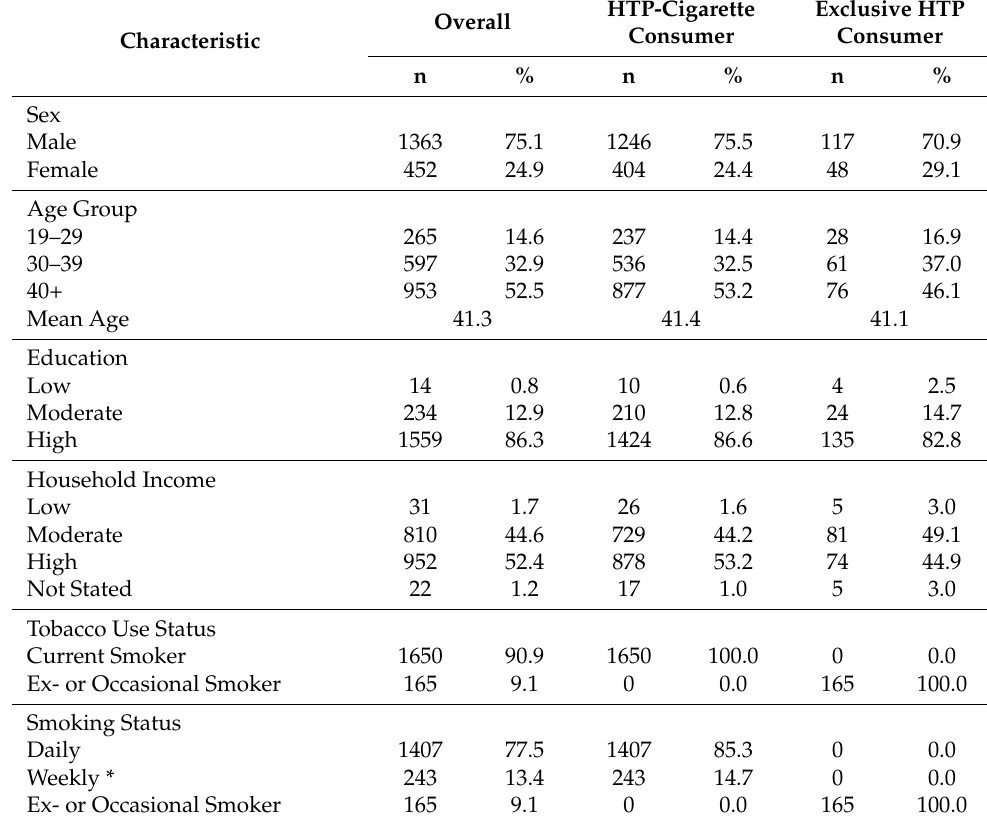
Table 2. Characteristics of all HTP